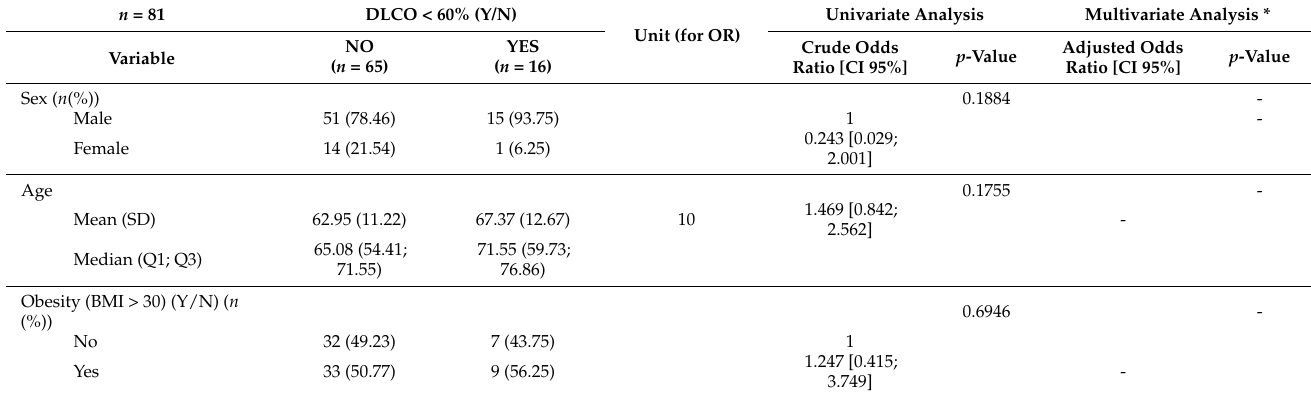
Table 3. Factors associated with decreased DLCO <